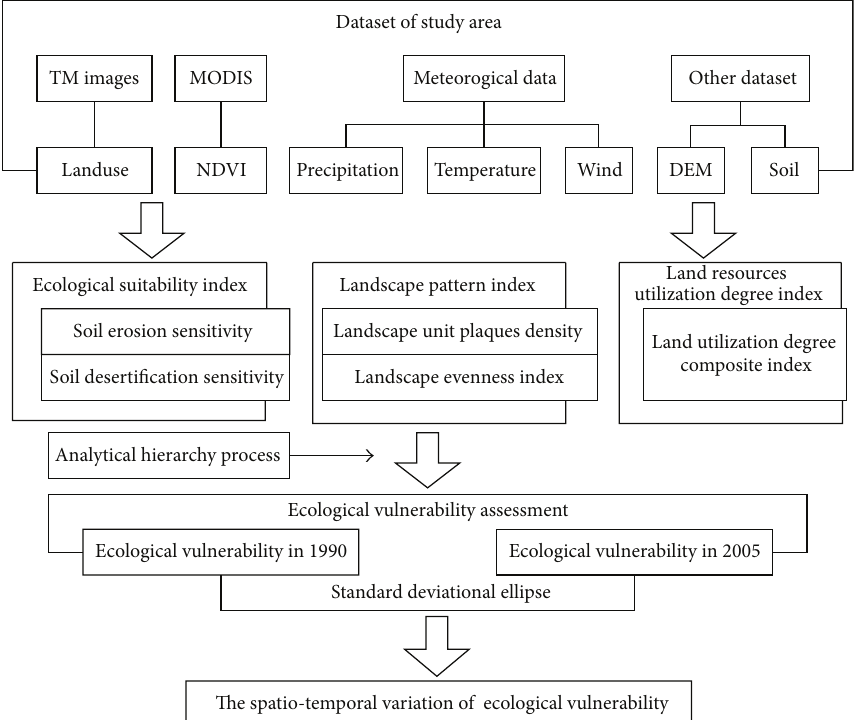
Figure 2: The workflow of ecological vulnerability assessment.